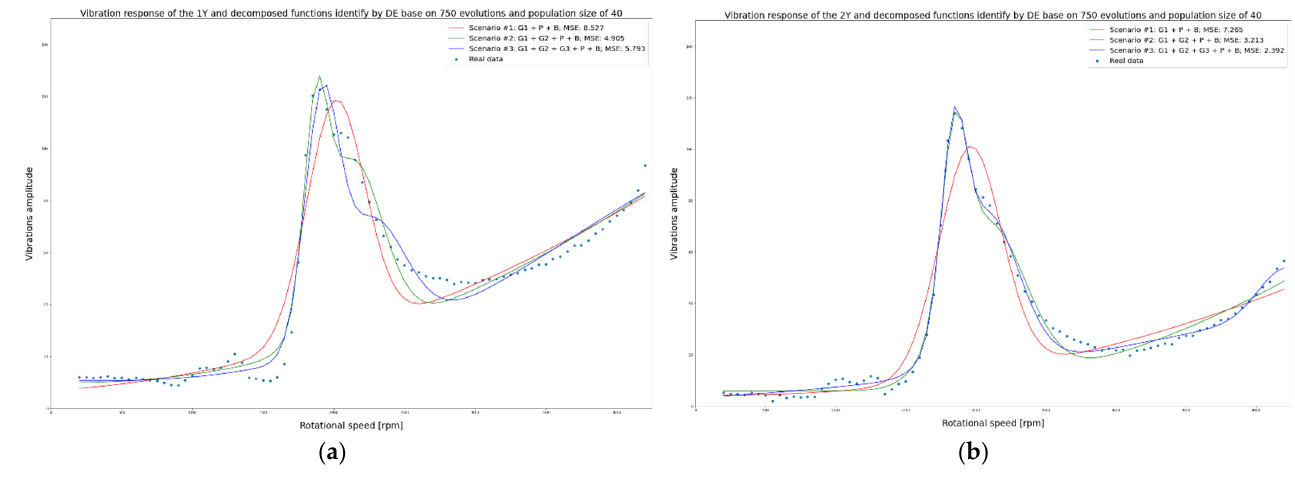
Figure 8. MD3 method outcome based on three scenarios proposed in Section 2 on a test rig with imbalance malfunction simulation: ( a ) Data obtained from the 1Y sensor, driven side of the rotor; ( b ) Data obtained from the 2Y sensor, non ‐ driven side of the rotor. Table 3. The MSE values are based on the scenario and sensor location for the imbalance simulation on the test rig.